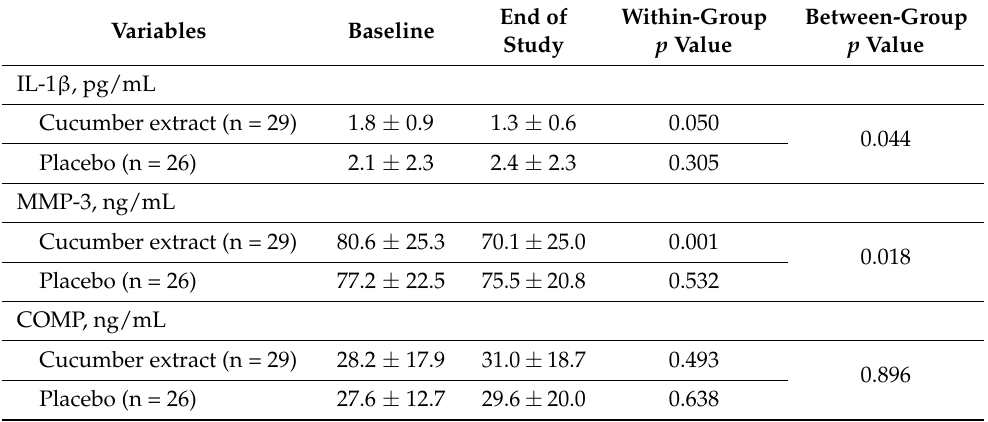
Table 7. Changes in plasma biomarkers after 8 weeks of supplementation with cucumber extract or